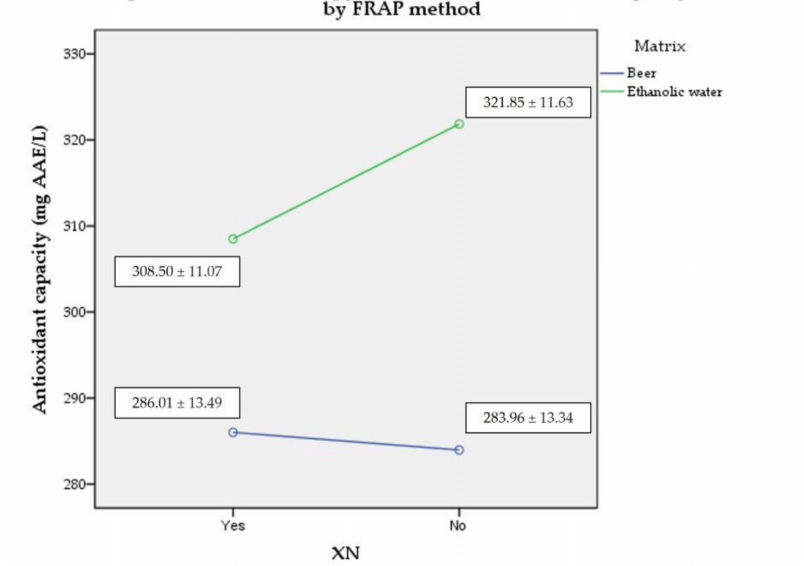
Figure 2. Mean ( ± SD) plasma antioxidant capacity values measured by FRAP method ( n = 5). Abbrevi- ations: AAE—ascorbic acid equivalent; FRAP—ferric reducing ability of plasma; XN—xanthohumol; SD—standard deviation.